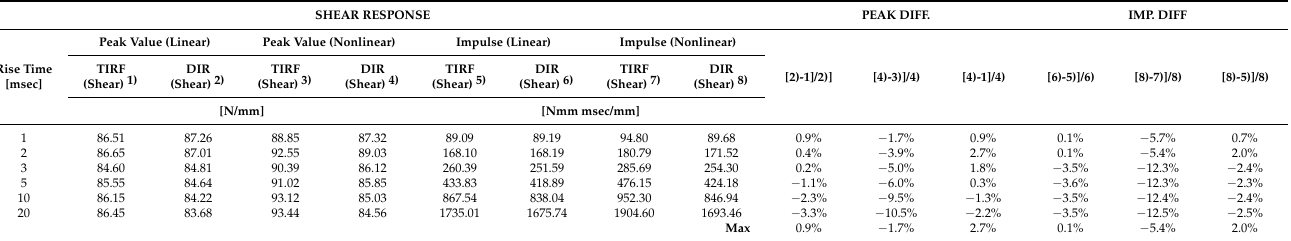
Figure 10. Box and whisker plots for the difference in the peak shear stresses and impulse values using TIRF and DIR.